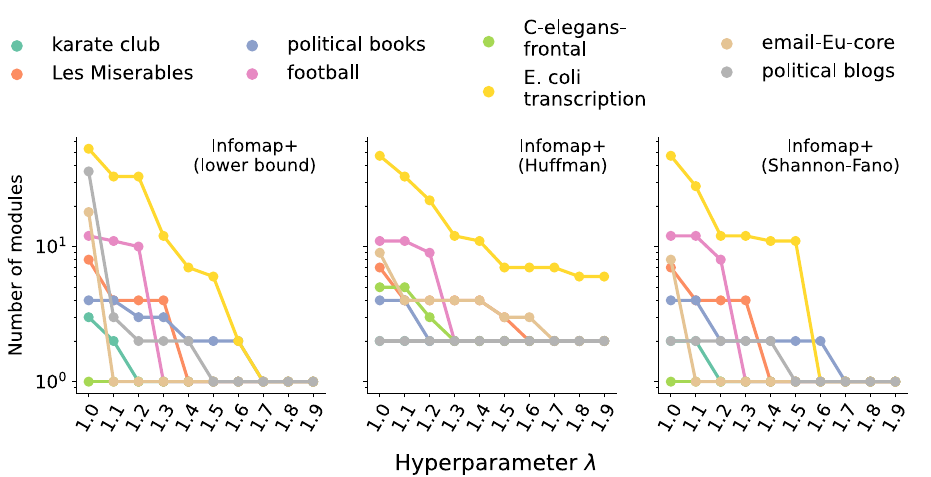
Figure 6. Number of modules identified for each value of the hyperparameter (cid:31) in